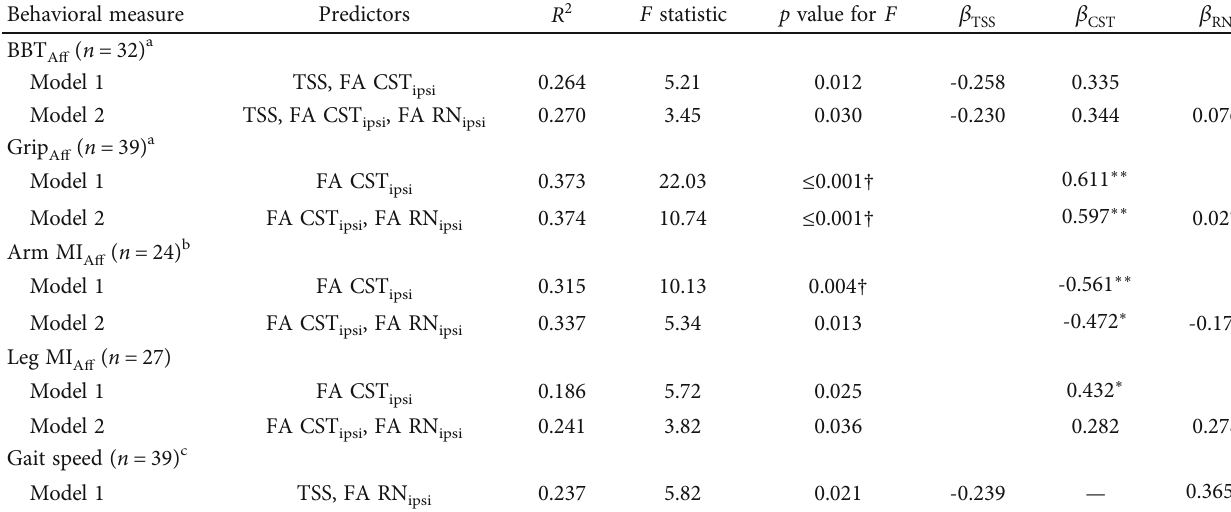
Table 2: Multiple regression analyses of tract/region-speci fi c FA and upper and lower limb motor performance. Behavioral